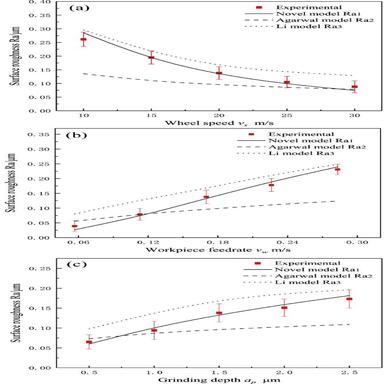
Comparison of predicted and measured surface roughness under various grinding parameters. (a) ap = 1.5 μm vw = 0.170 m/s (b) ap = 1.5 μm vs = 20 m/s (c) vw = 0.170 m/s vs = 20 m/s.